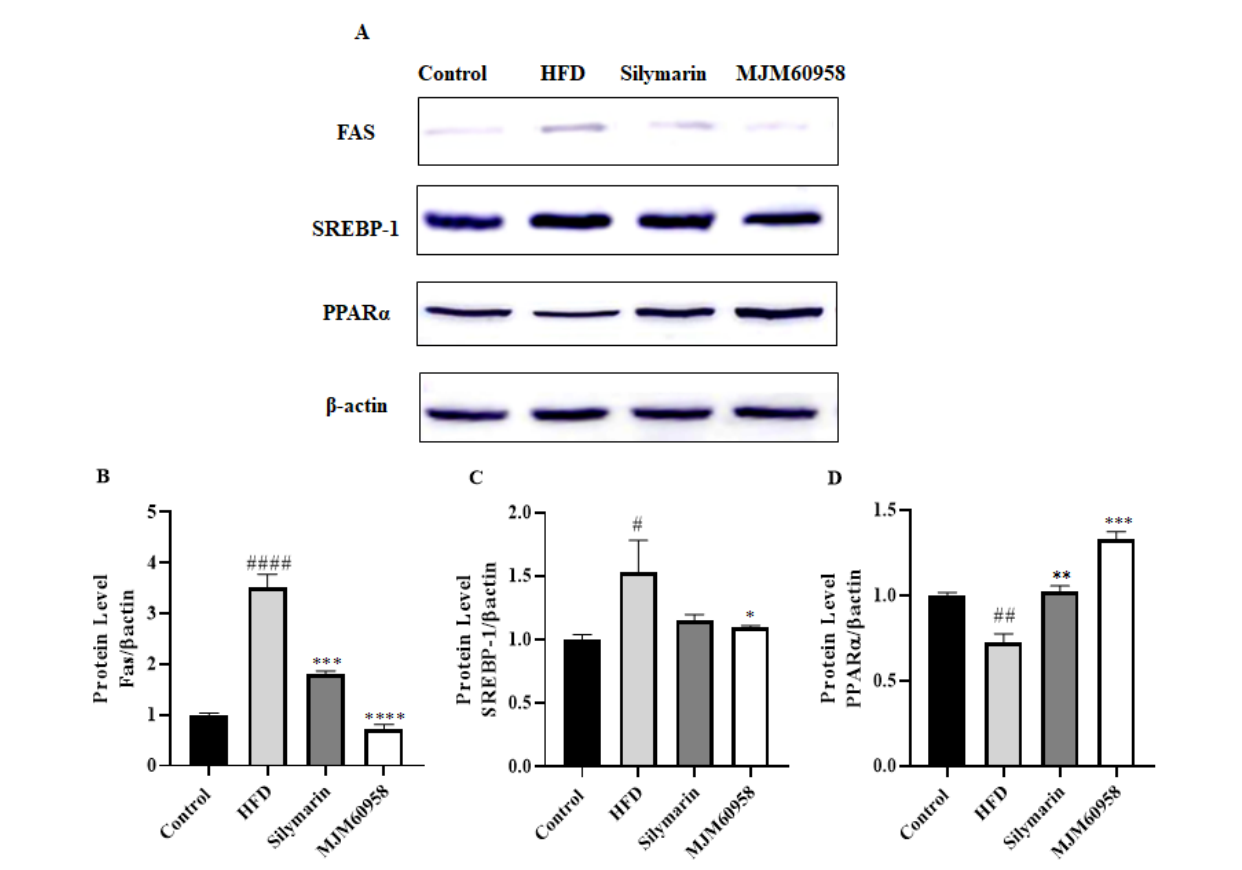
Figure 6. Effect of MJM60958 on FAS, SREBP-1 , and PPARα protein levels in liver tissues of mice fed either HFD, L. sakei MJM60958, or silymarin for 12 weeks. ( A ) Protein expression was determined by Western blotting and protein expression of ( B ) fatty acid synthase/β -actin, ( C ) Sterol regulatory element-binding protein 1 /β -actin, ( D ) peroxisome proliferator- activated receptor alpha /β -actin were quantified using the ImageJ program. Data are expressed as the means ± standard deviation of triplicate independent experiments. # p < 0.05, ## p < 0.01, #### p < 0.0001 compared with control group; * p < 0.05, ** p < 0.01, *** p < 0.001, **** p < 0.0001 compared with HFD group.